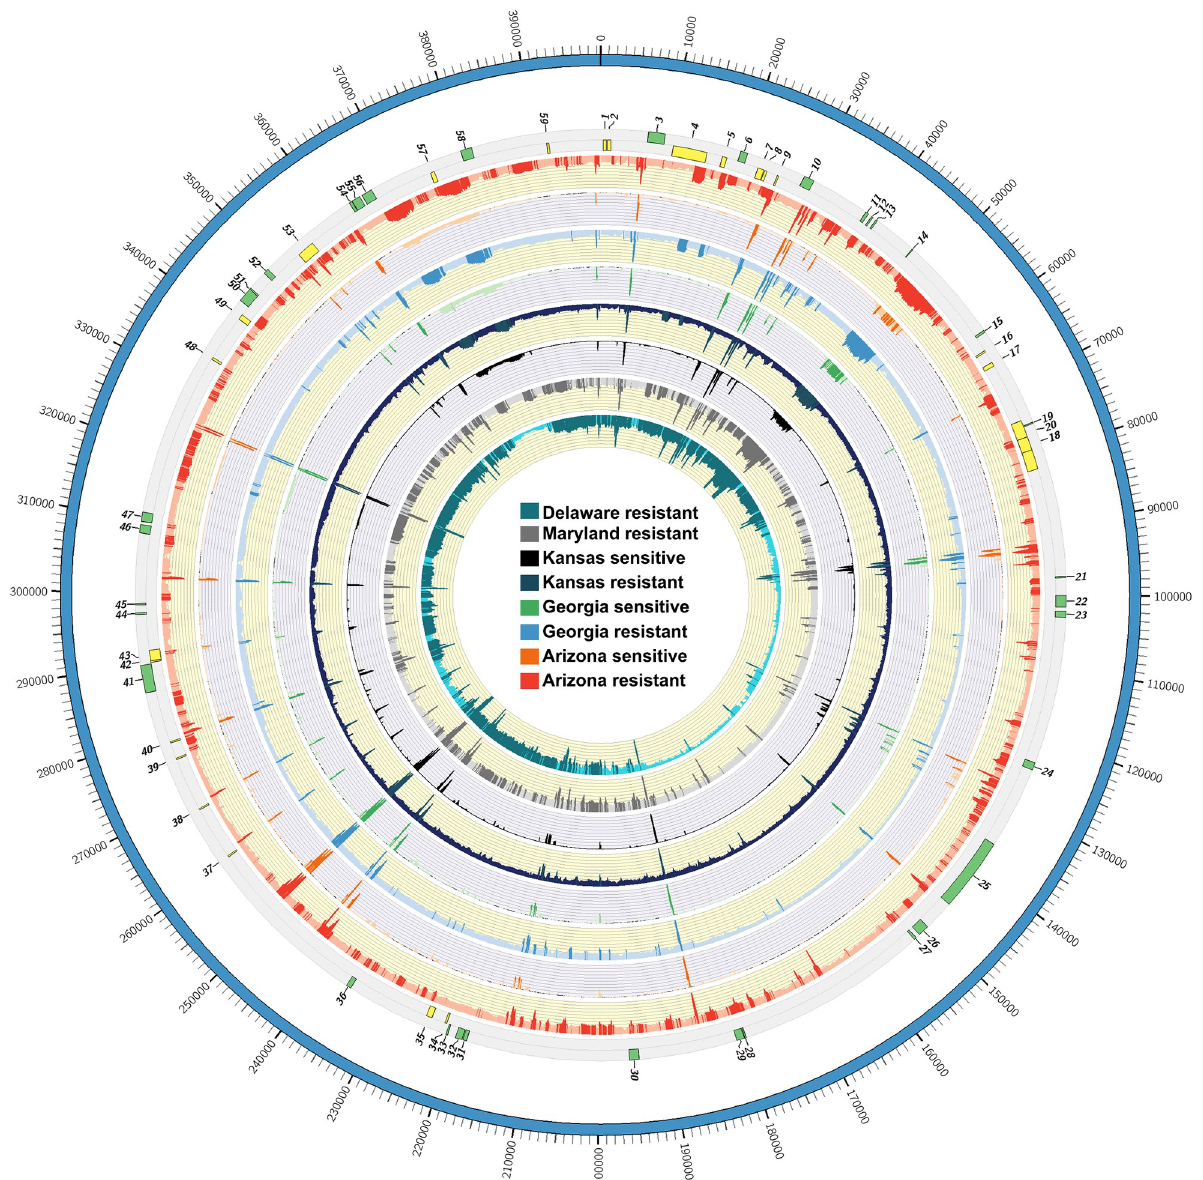
Fig 3. Mapping and alignment of WGS reads from R and S plants (a) Mapping and alignment of WGS reads from GR and GS plants from different locations and populations from across the USA to the EPSPS replicon. https://doi.org/10.1371/journal.pone.0233813.g003 PLOS ONE | https://doi.org/10.1371/journal.pone.0233813 September 9,